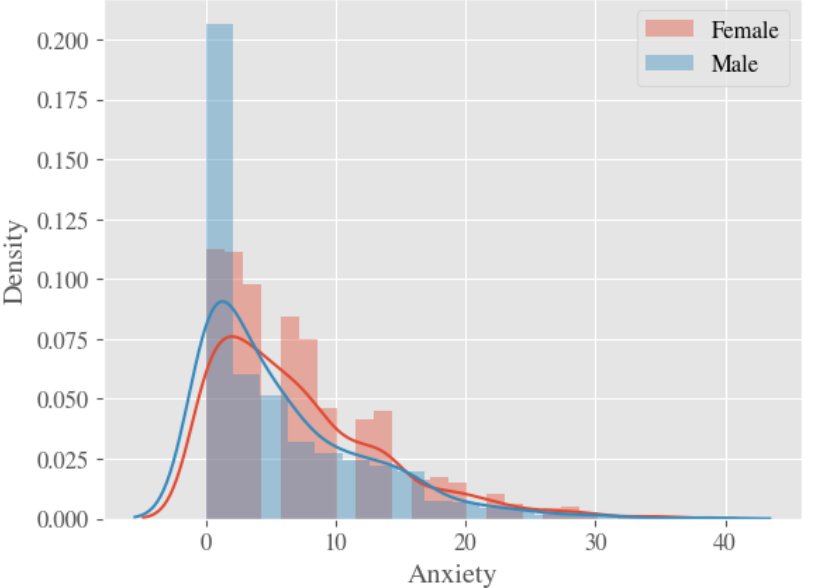
Figure 4. The Distribution of Levels of the Impacts of COVID-19 in Men and Women.